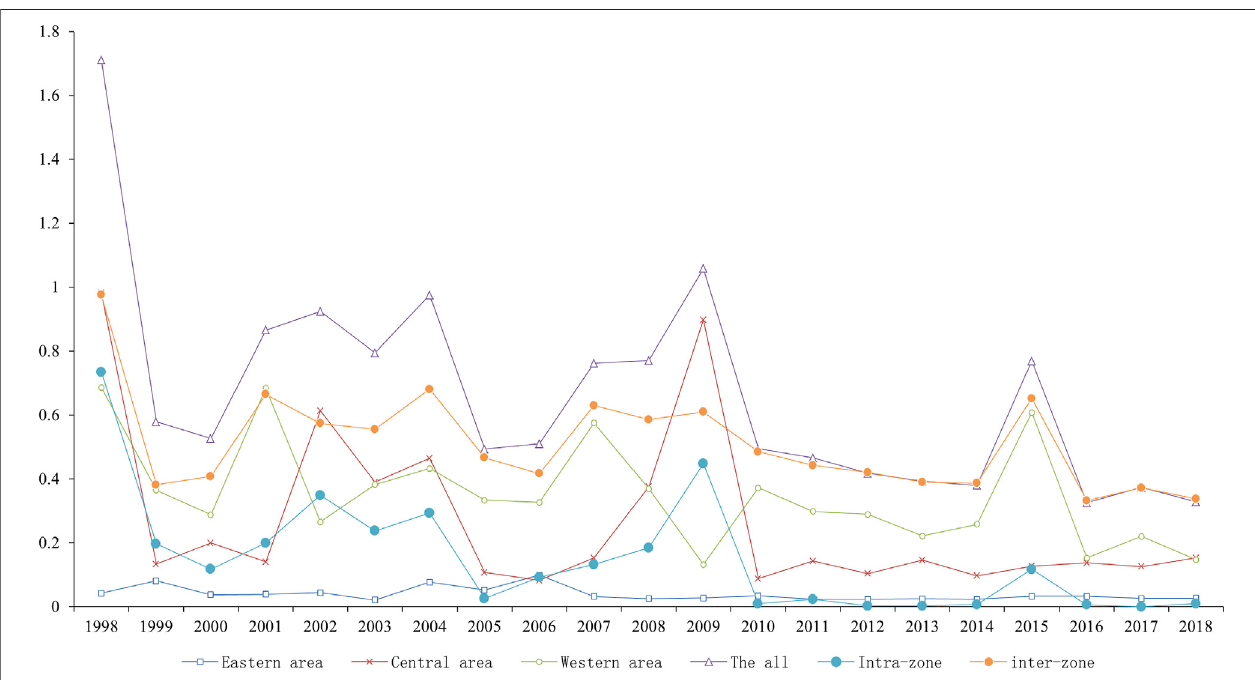
FIGURE 3 | Agricultural Green technological progress Carbon Emission Reduction Potential Theil Index (1998 – 2018).